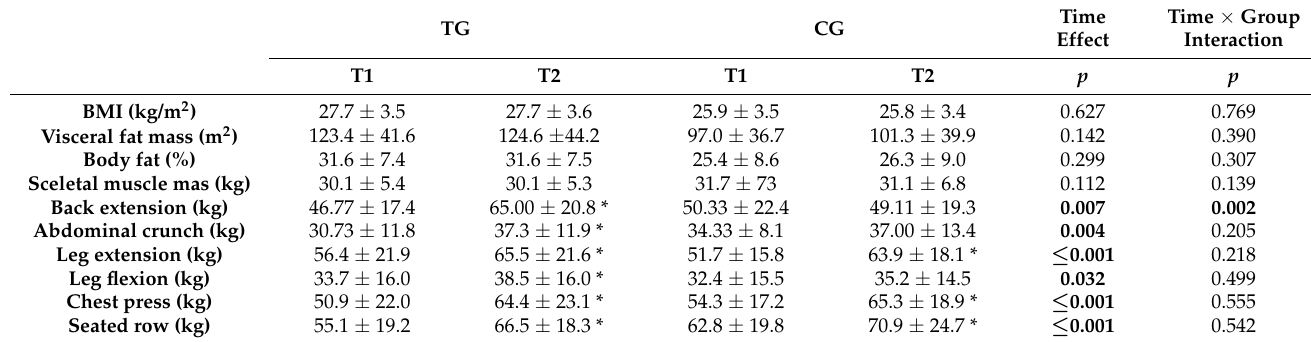
Table 2. Anthropometrics, health status and physical capacity parameters at time point 1 (T1) and T2 in training group (TG) and control group (CG) (mean ± SD).